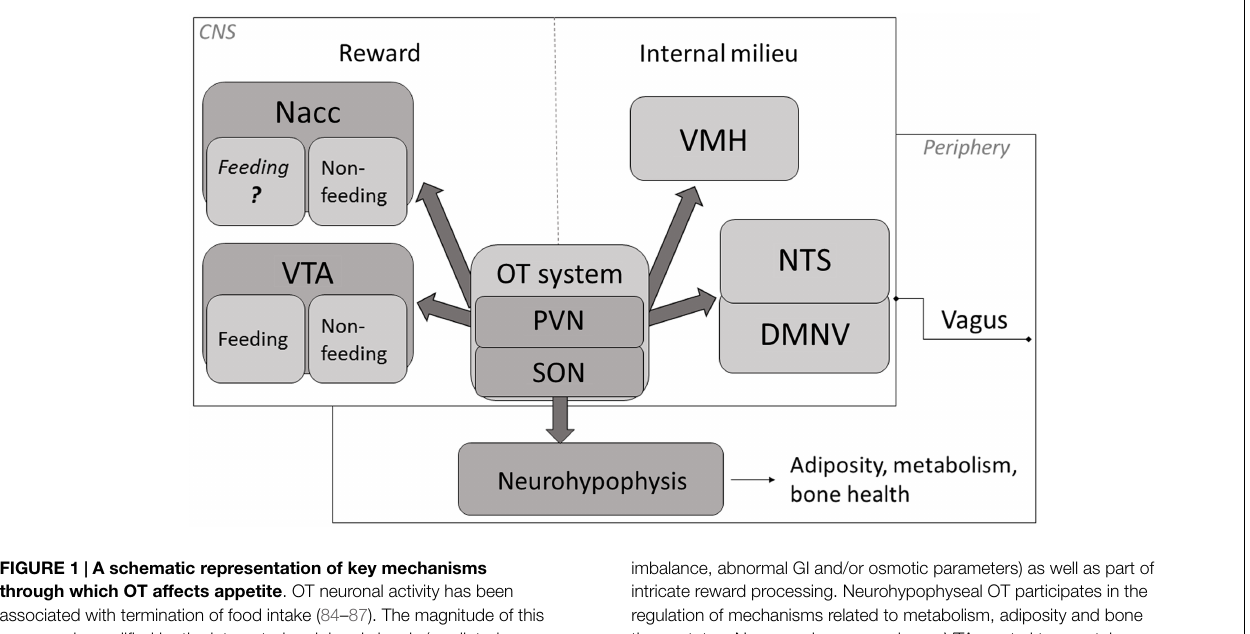
FIGURE 1 | A schematic representation of key mechanisms through which OT affects appetite . OT neuronal activity has been associated with termination of food intake (84–87). The magnitude of this response is modified by the integrated peripheral signals (mediated largely via the vagus and the brainstem relay circuit) and by the rewarding value of a meal (74, 84, 88, 89). Release of OT in the CNS promotes termination of consumption when internal milieu is jeopardized (energy